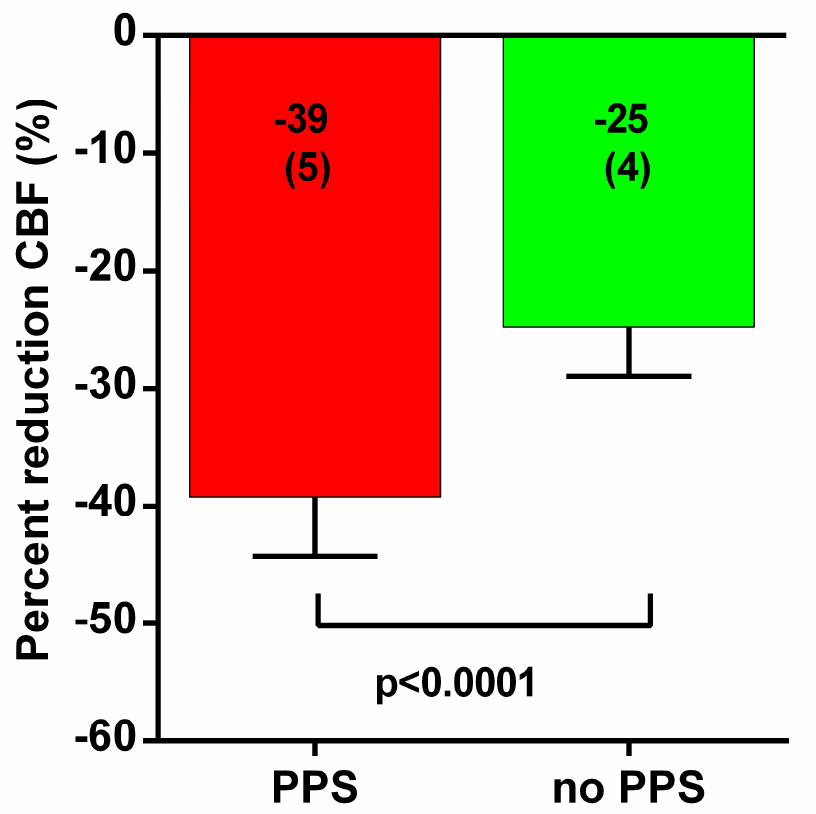
Figure 1. Percent reduction cerebral blood flow end-tilt versus supine in patients with psychogenic pseudosyncope (PPS) (red bar) and patients without psychogenic pseudosyncope (green bar).